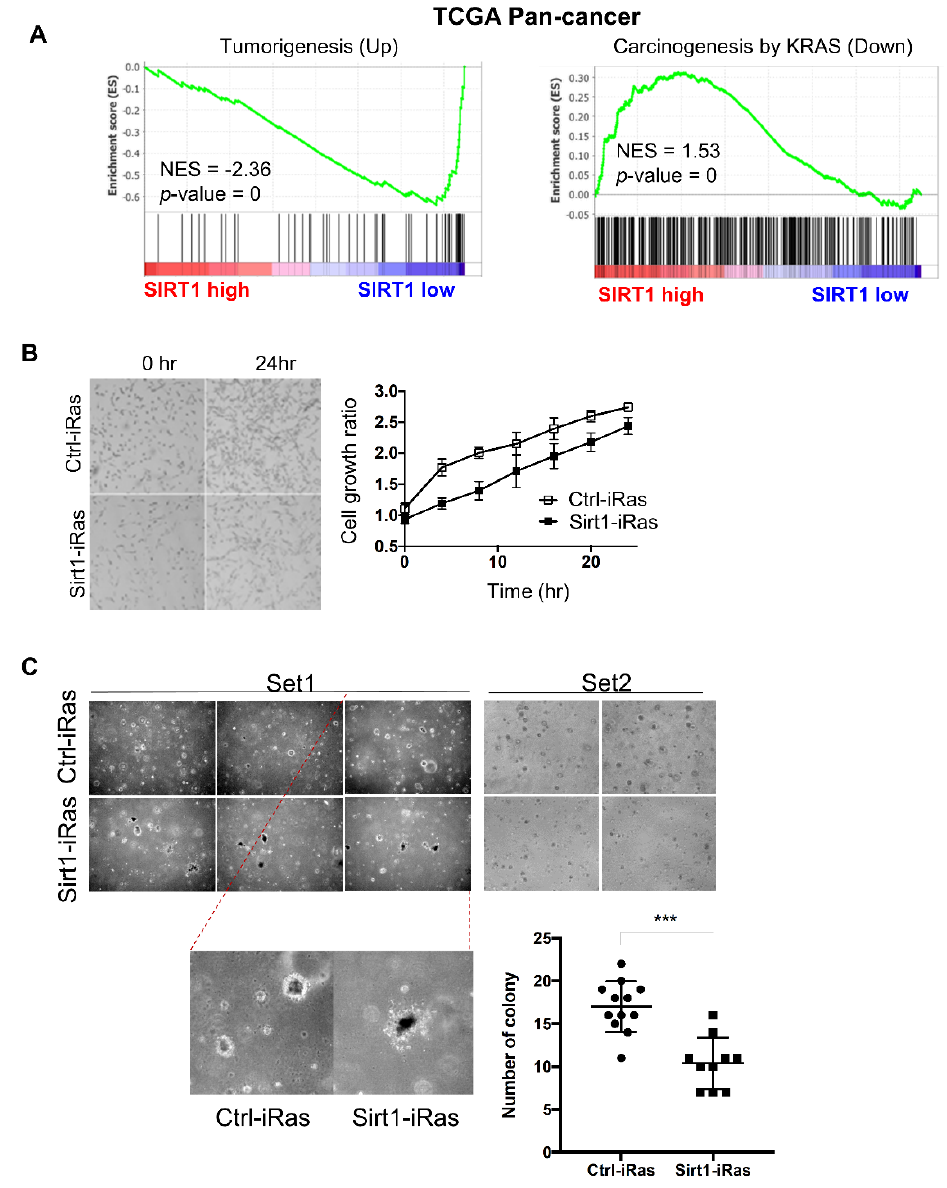
Figure 2. SIRT1 suppresses tumorigenesis. ( A ) Gene set enrichment analysis (GSEA) plots showing the enrichment of tumorigenesis-related genes in a ranked list of genes di ff erentially expressed between SIRT1 -high and -low groups in TCGA pan-cancer cohort ( n = 9435). Tumorigenesis-related gene sets were obtained from MSigDB: ‘CROMER TUMORIGENESIS UP’ (left) and ‘IWANAGA CARCINOGENESIS BY KRAS PTEN DN’ (right). The normalized enrichment score (NES) and nominal p-value were calculated by the GSEA tool. ( B ) Comparison of growth rates between Ctrl-iRas and Sirt1-iRas cells. The cell proliferation rate was assessed by the JuLI stage at each time point. Representative images (left, original magnification, 40 × ) and growth curves (right) of Ctrl-iRas and Sirt1-iRas NIH3T3 cells. ( C ) The soft-agar assays were performed in Ctrl-iRas or Sirt1-iRas NIH3T3 cells with doxycycline (Dox) treatment. Representative images of soft-agar assay (left, original magnification, 40 × ) and a dot plot represents the number of colonies (right).